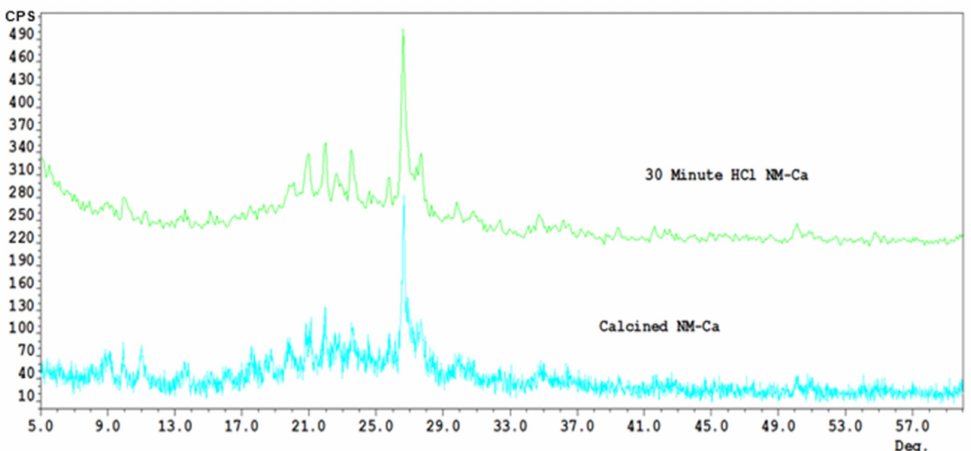
Figure 8. The XRD patterns of calcined NM-Ca and 30 min HCl